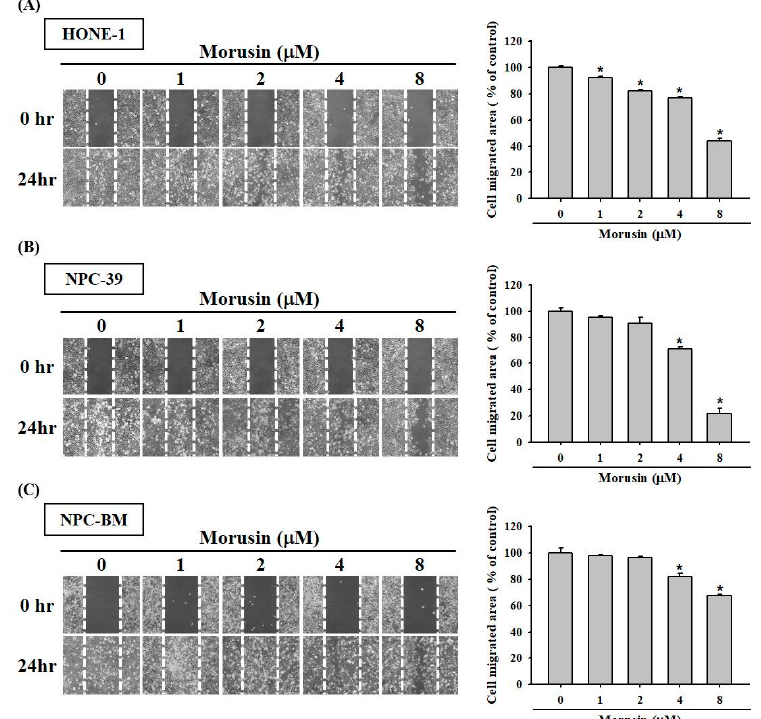
Figure 2. Effect of morusin on cell wound closure in human NPC cells. Wound healing assay evaluated the effect of morusin on cell motility of HONE-1 ( A ), NPC-39 ( B ) and NPC-BM ( C ) cells lines at various concentrations by microscope (at 100× magnification). The data are presented as mean ± SD from at least triplicates independent experiments. * p < 0.05 compared with untreated.